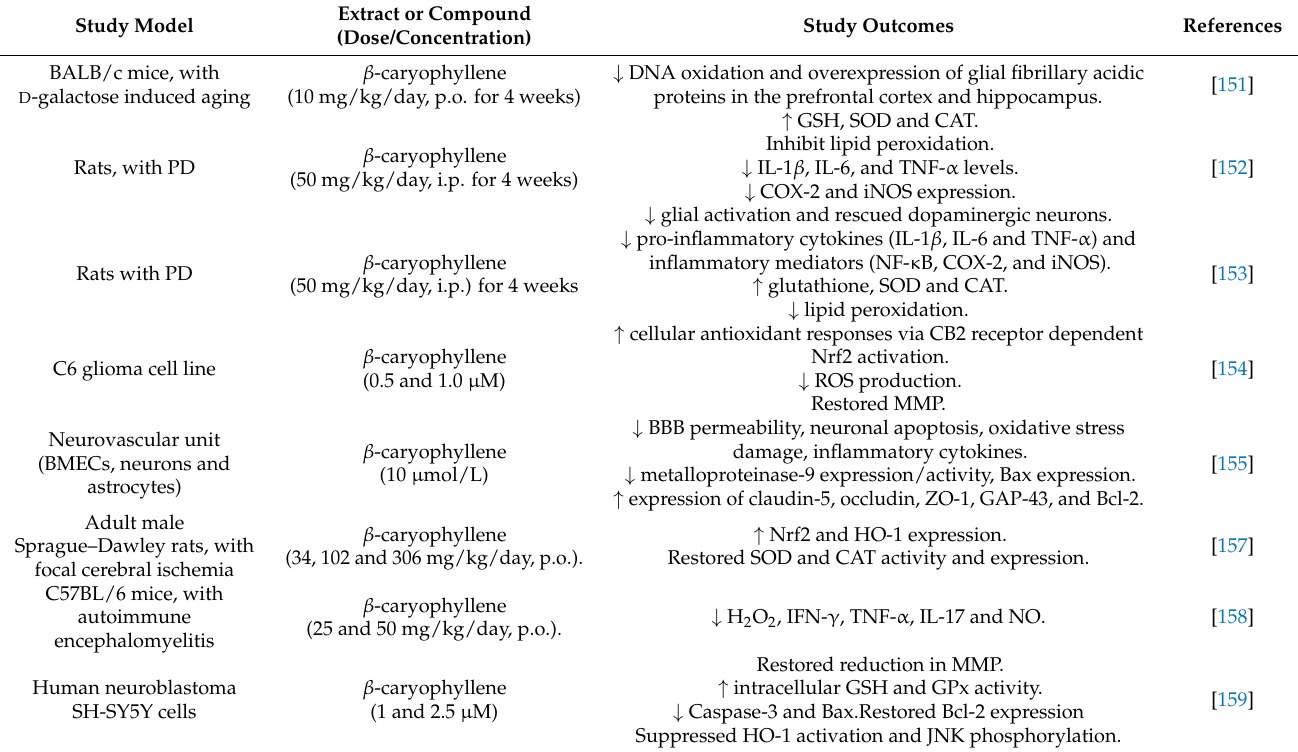
Table 2. Alteration of oxidative stress and mitochondrial dysfunction by β -caryophyllene and vegetable extracts containing β